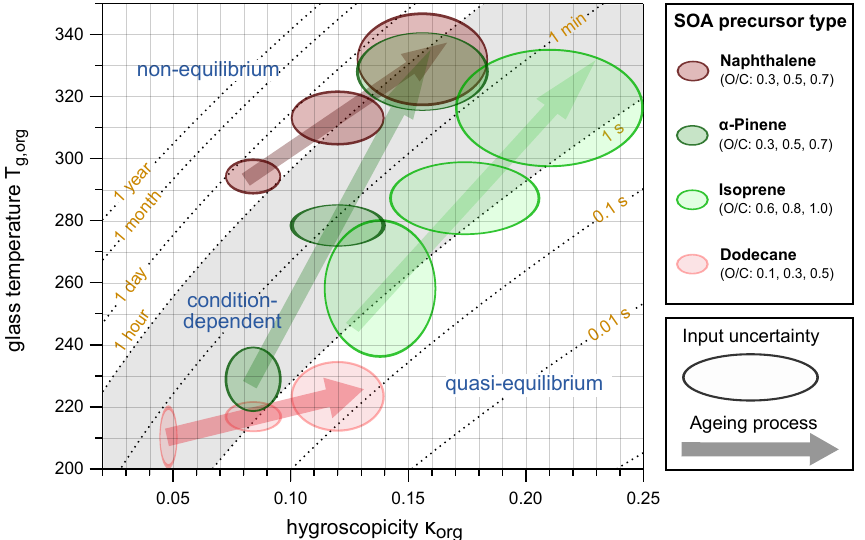
Figure 4. Characteristic timescales of water diffusion in SOA as a function of hygroscopicity, κ org , and glass transition temperatures of the pure organic matrix, T g,org . Calculations have been performed at 220K, S ice = 1 . 45 and for 100nm particles. Oval shapes confine estimated ranges in κ org and T g,org for the four SOA types in three different oxidation states (Appendix A and Table A1). The grey area indicates the timescale of typical atmospheric updrafts (1s to 1h) and thus divides the plot into areas of quasi-equilibrium and non-equilibrium water diffusion. Within the grey area, the relative speed of both processes depends upon the actual atmospheric conditions. The ageing process is indicated by arrows pointing from regions of low O / C to regions of high O /